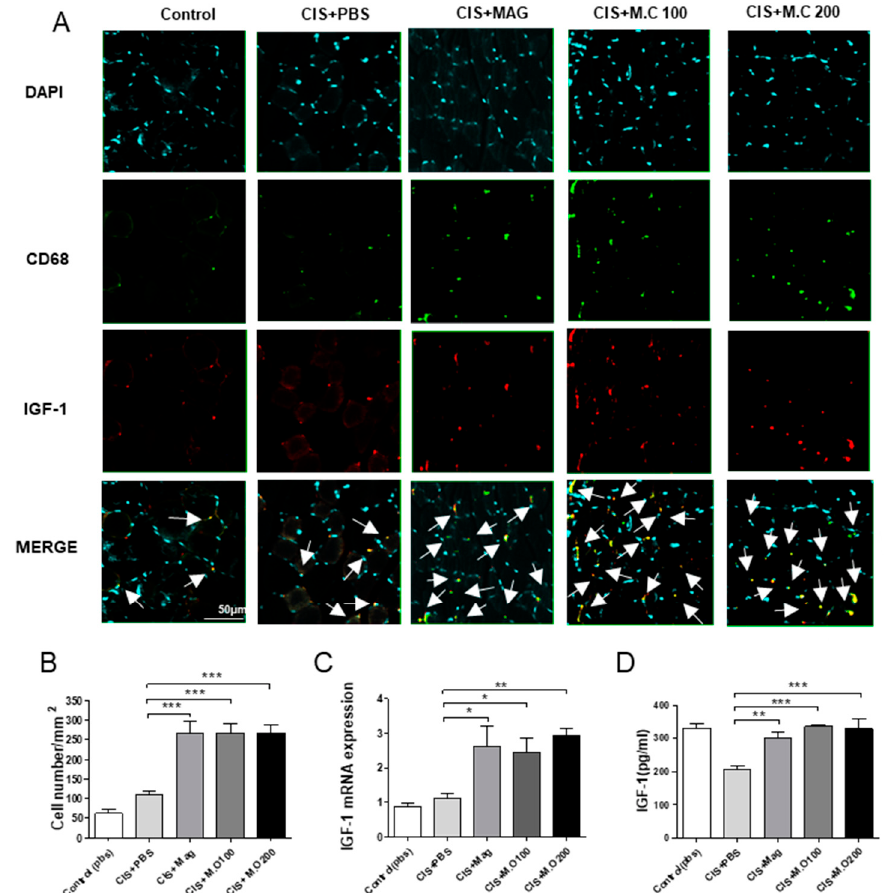
Figure 5. M.C increased the number of macrophages and the expression of IGF-1 in the TA muscle: ( A ) Immunohistochemistry (IHC) showing CD68 (macrophages, green) and IGF-1 (red) staining in the TA muscle. (Magnification: 40 × , scale bar 50 µ m). Nuclei are stained with diamidino-2-phenylindole (DAPI) (blue). Merge = IGF-1 + CD68 + DAPI and merged places are indicated by white arrows. ( B ) The number of IGF-I, CD68, and DAPI positive cells per image area measured on at least five random fields. ( C ) IGF-1 mRNA expression in the TA muscle tissue measured by qPCR. ( D ) IGF-1 protein expression in the TA muscle tissue was quantified using ELISA. Data are presented as the mean ± SEM ( n = 4~5/group). * p < 0.05, ** p < 0.01, *** p < 0.001 vs. CIS+PBS, using a Bonferroni post hoc test after one-way